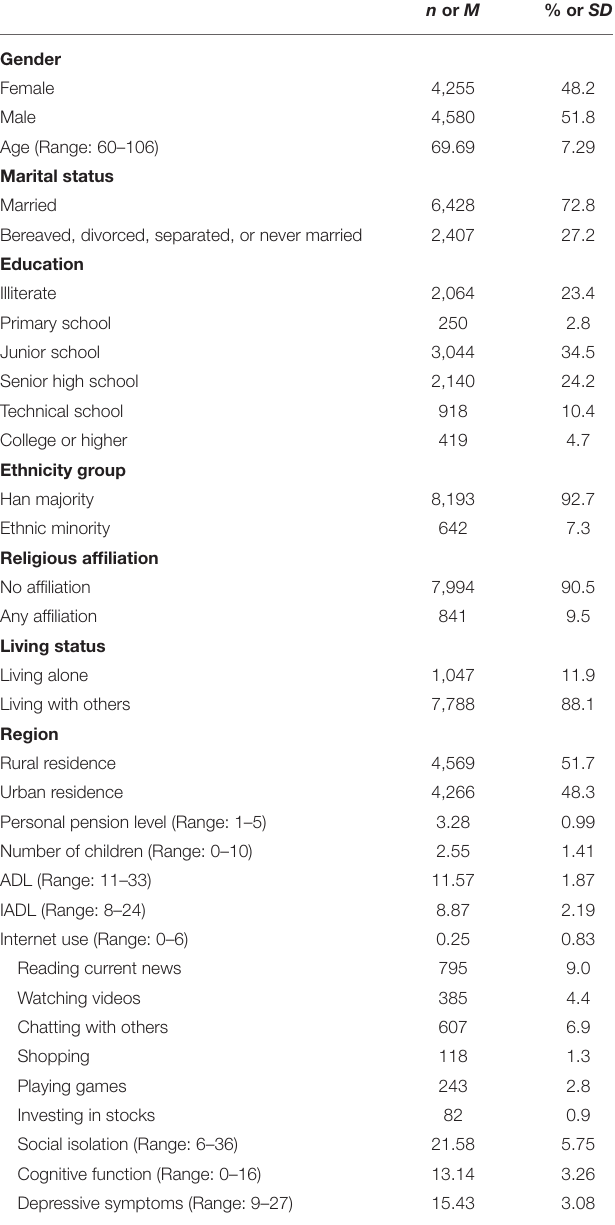
TABLE 1 | Descriptive statistics of analytic variables ( N = 8,835). TABLE 2 | A hierarchical regression analysis for moderating effects in the relationship between social isolation and cognitive function ( N =